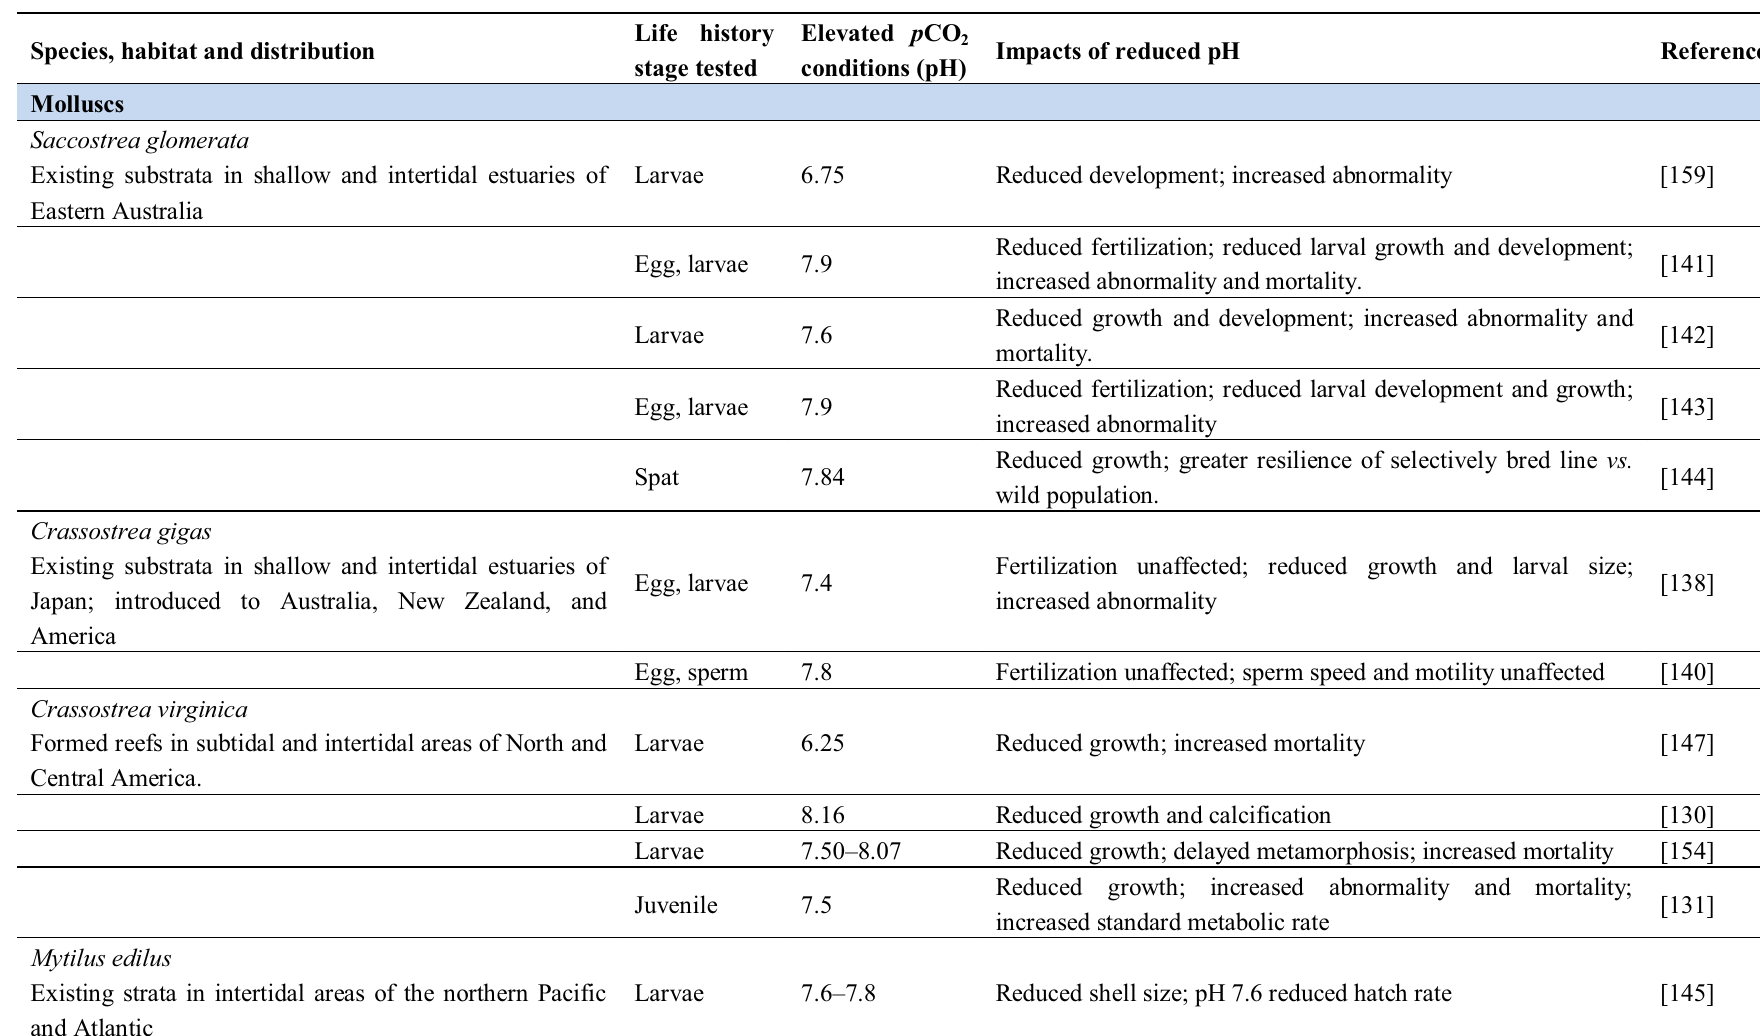
Table 1. The impacts of ocean acidification and temperature on estuarine organisms and molluscs and